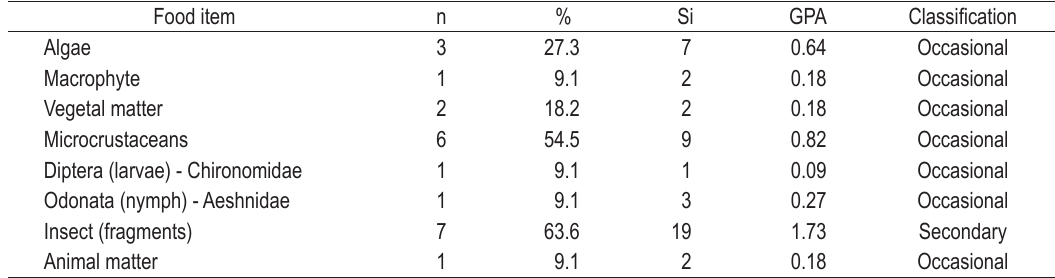
Table 1. Classification of food items consumed by Serrapinnus heterodon from Mogi Guaçu reservoir. Food